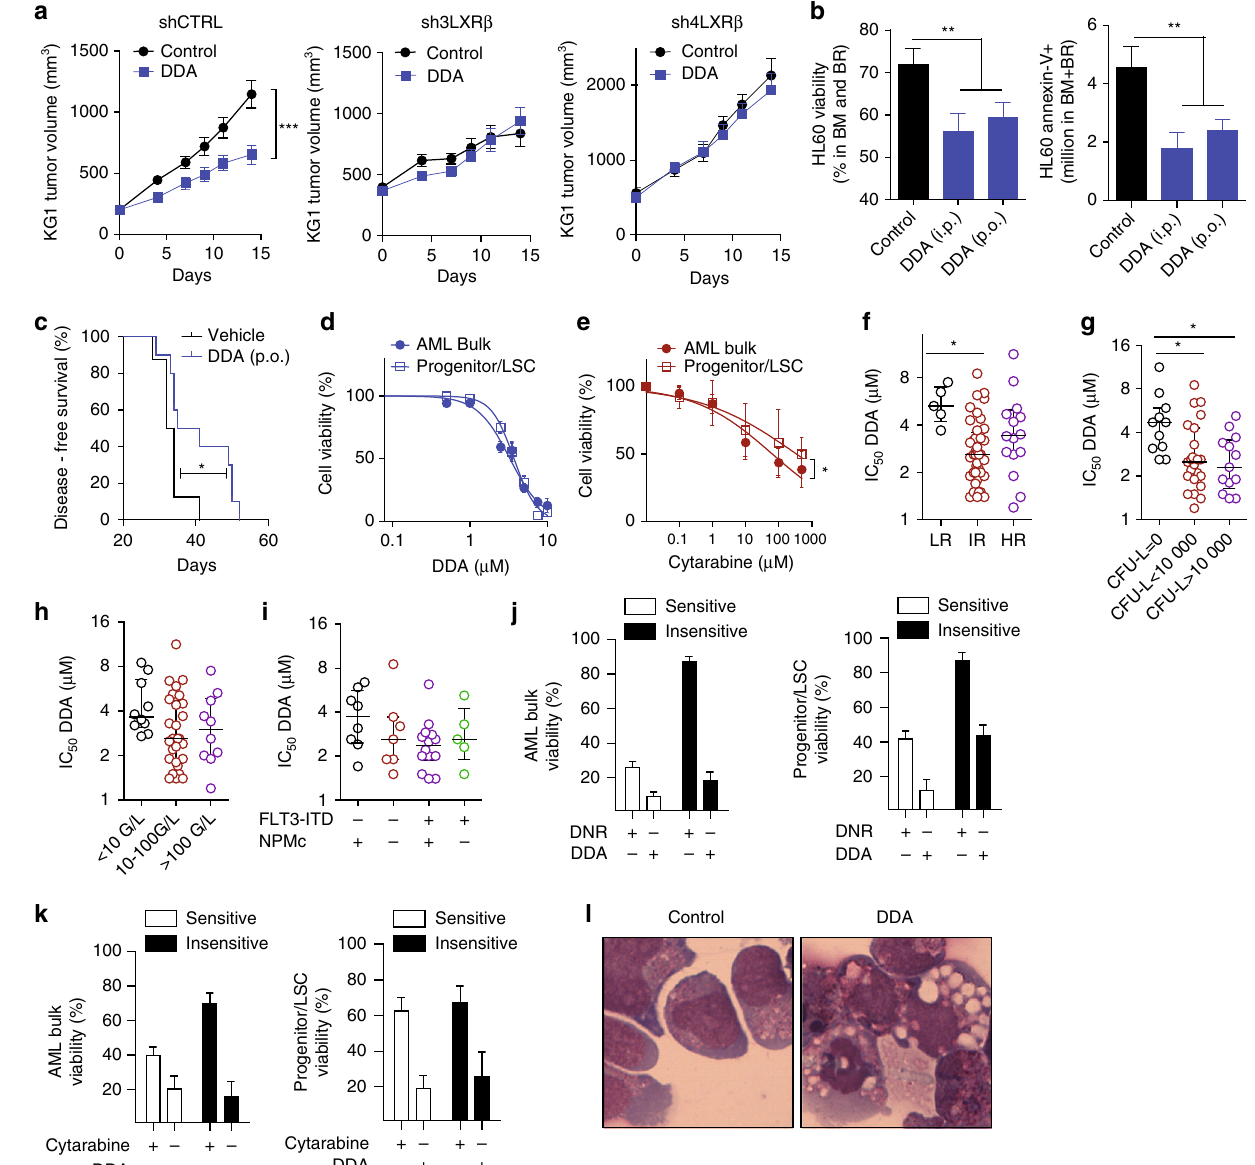
Fig. 7 DDA induces an LXR β -, Nur77-, and NOR1-dependent lethal autophagy in AML. a Tumor volume curves of xenografts of cells transfected with shCTRL, sh3LXR β , and sh4LXR β and implanted into NOD/SCID mice (20 per group) who were then treated daily with DDA (20 mg/kg/day, i.p.) or solvent vehicle. b HL60 cells were injected i.v. into irradiated NSG mice ( n = 10 per group) who were then treated daily with DDA (20 mg/kg/day, i.p. or 40 mg/ kg/day, p.o.) for 16 days. Analyses of HL60 cell contents and viability in bone marrow (BM) and brain (BR) of NSG mice. Cells were quanti fi ed by fl ow cytometry using human anti-CD45 and human anti-CD33 antibodies (left panel) and viability was determined by Annexin-V staining (right panel). c Overall survival was determined for NSG mice ( n = 10 per group) engrafted with HL60 cells and treated, after disease establishment, with control (vehicle) or DDA (40 mg/kg/day, p.o.), * P < 0.05, log-rank test. Samples from AML patients ( n = 61, Supplementary Data 1) were exposed to increasing concentrations of DDA ( d ) or cytarabine ( e ) for 48 h. Cell death was assessed both in the AML bulk and in the progenitor/LSC cells (CD34+CD38 − CD123 +) using Annexin-V/7AAD staining. Data are represented as the percentage of survival. Scatter plots comparing DDA ef fi cacy in primary AML patients according to f their prognostic risk category (LR: low risk, IR: intermediate risk, and HR: high risk), g CFU-L formation, h total white blood count, and i their Flt3-ITD and NMP1 status. Samples from AML patients were exposed to 10 nM daunorubicin (DNR) j or 100 µ M cytarabine k with or without 5 µ M DDA for 72 h. “ daunorubicin insensitive ” or “ cytarabine insensitive ” when cell death was lower than 20%, and “ sensitive ” when cell death was over 70%. Bars represent S.E.M. l Images of primary AML cells stained with MGG after treatment with vehicle or DDA for 24 h. Images are representative of three independent experiments. Data from a-e are means ± S.E.M., and is representative of 3 – 5 independent experiments, ** P < 0.01, t -test. d – k Bars represent